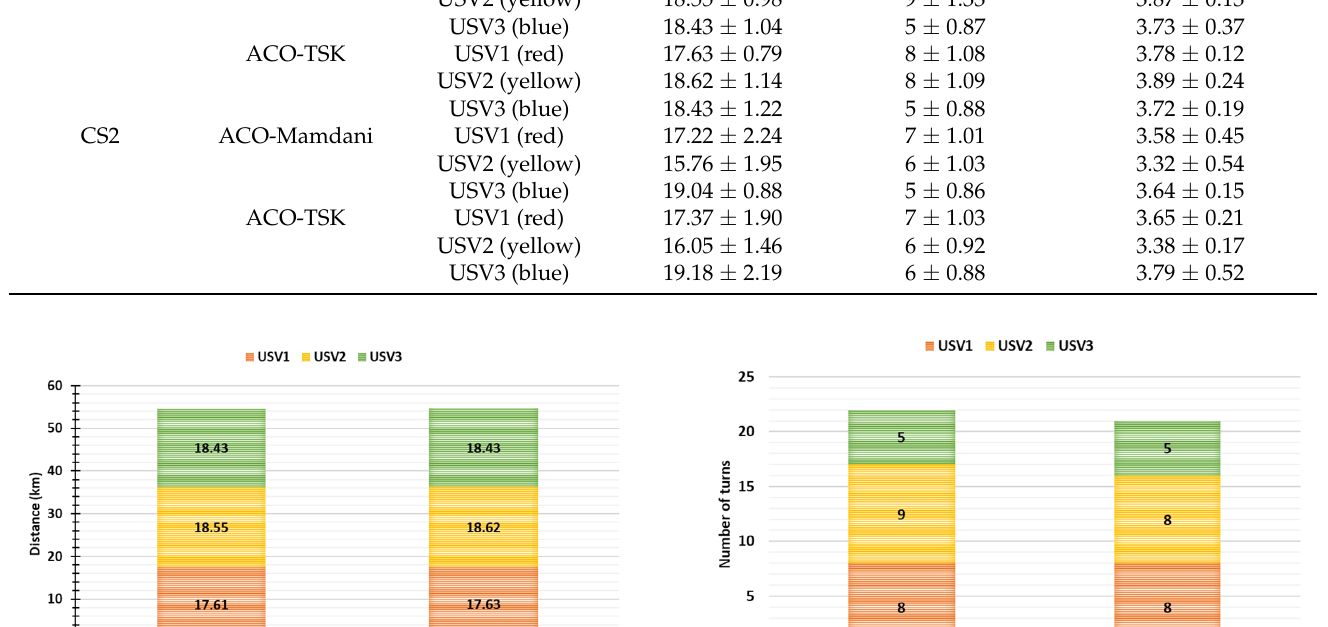
Table 4. Path planning optimality and computing time mean results with standard deviation after 20 runs of the case studies for each ACO-FIS approach for the swarm of USVs. The best solutions are denoted in bold.